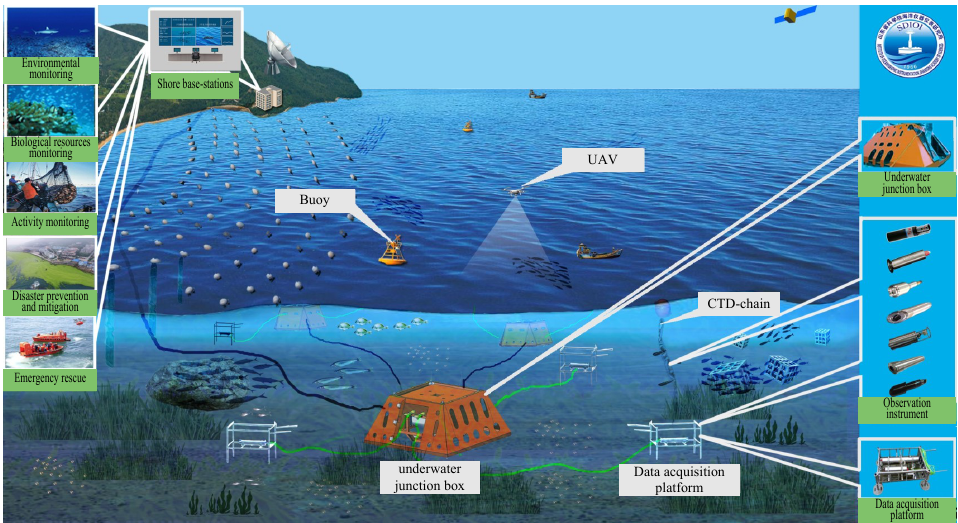
Figure 7. Underwater junction box observation network